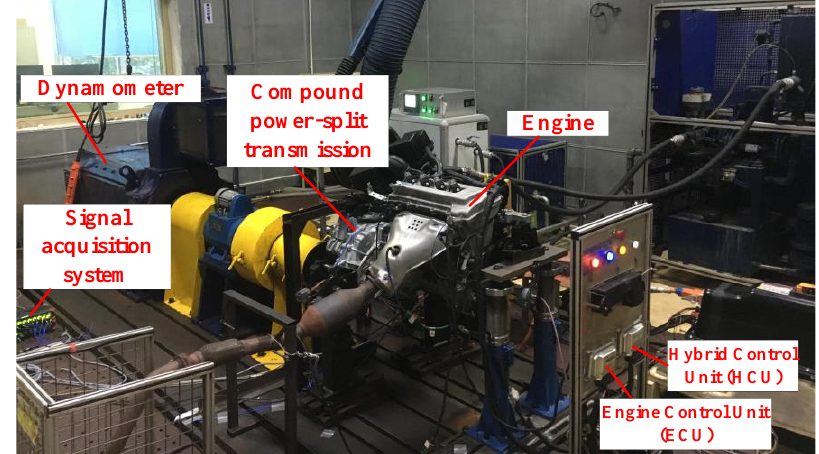
Figure 4. Test bench for a PS-PHEV.